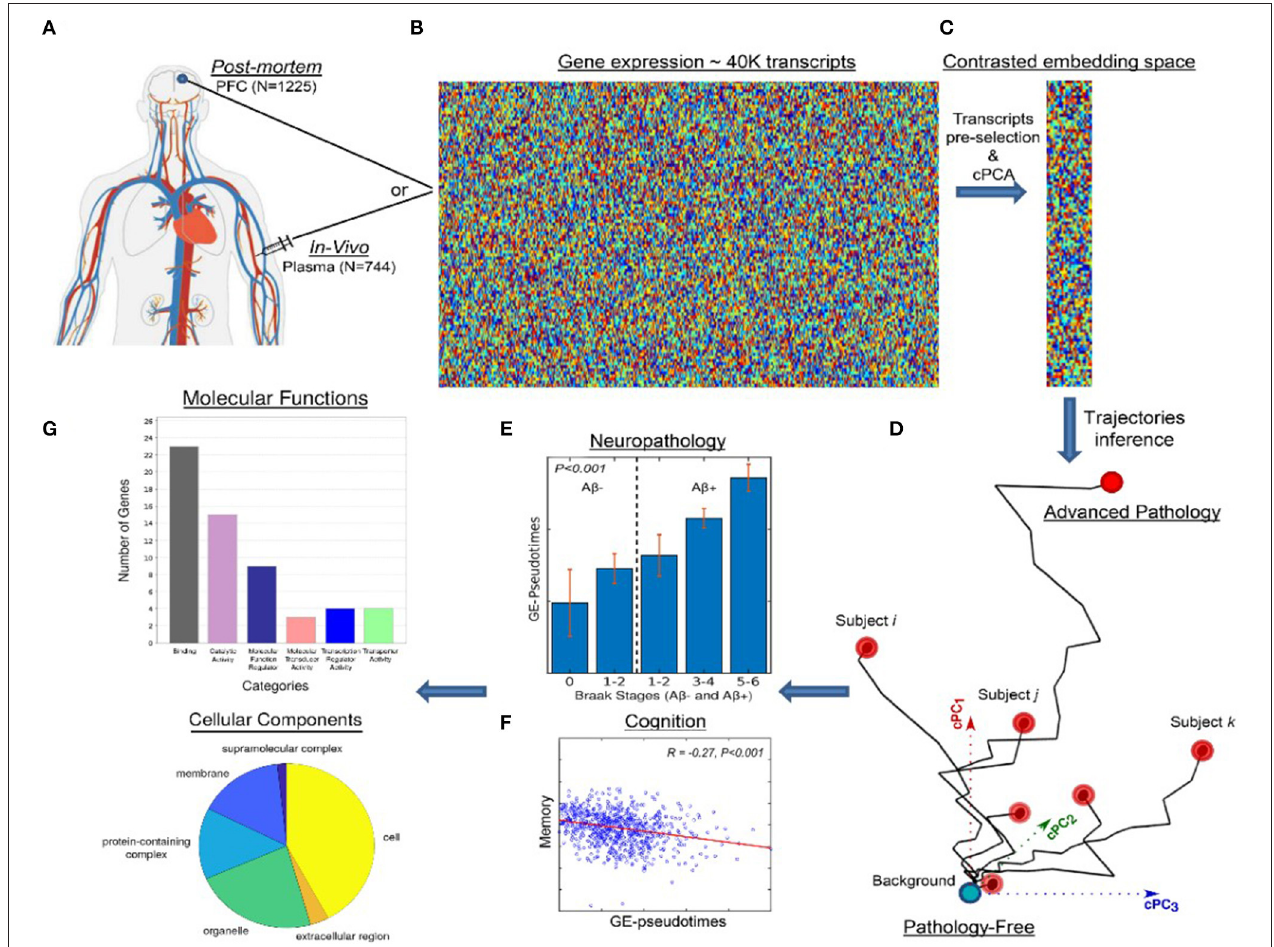
FIGURE 4 | Schematic approach for detecting molecular disease-associated patterns and patient staging. In-vivo blood ( N = 744; ADNI) and post-mortem brain ( N = 1,225; ROSMAP, HBTRC) tissues (A) are screened to measure the activity of ∼ 40,000 transcripts (B) . This high dimensional data is reduced to a set of disease-associated components (C) via contrastive PCA and/or variational autoencoders 0.171. This allows to represent each subject in a disease-associated space (D) where the corresponding position reflects her/his pathological state (with proximity to the left bottom corner implying a pathology-free state and to the right top corner implying advanced pathology). An individual molecular disease score is then calculated, reflecting how advanced is each subject in his/her disease-trajectory. This score significantly predicts neuropathological (E) and cognitive measurements (F) . Finally, the resulting model weights allow the direct identification and posterior functional analysis of most influential genes (G) . Image adapted with permission from Iturria-Medina et al.